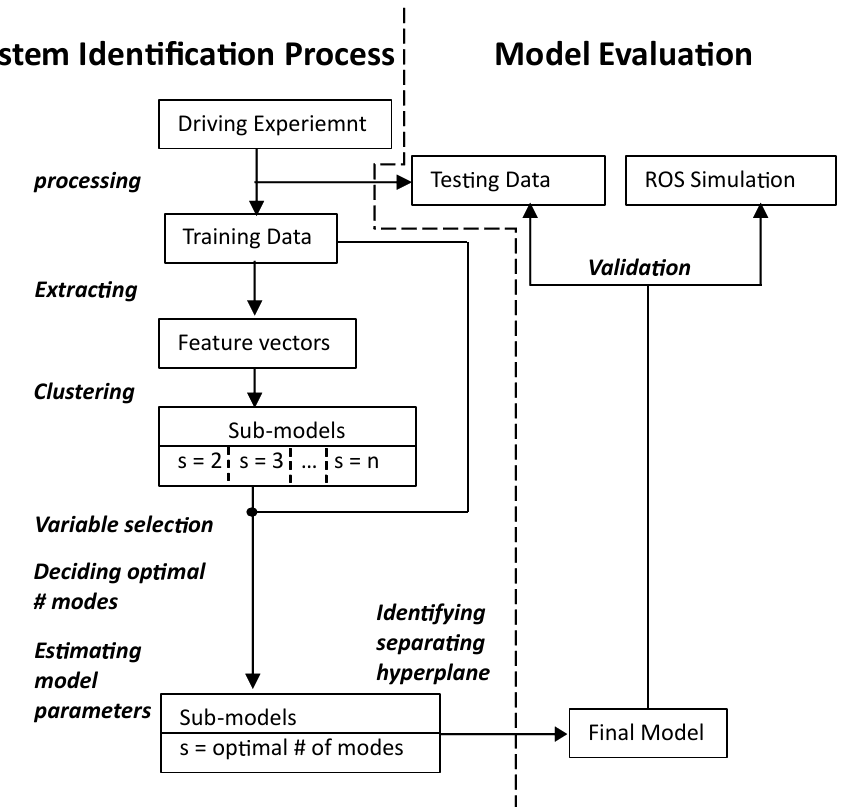
Figure 1. Overview of the proposed